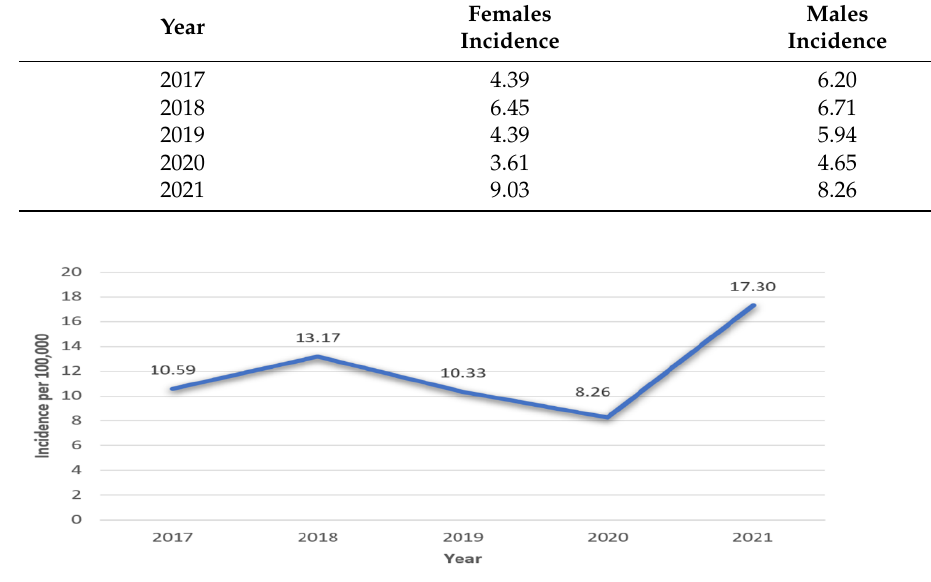
Figure 1. Incidence rates (per 100,000) of T1DM during 2017–2021 in Vojvodina.